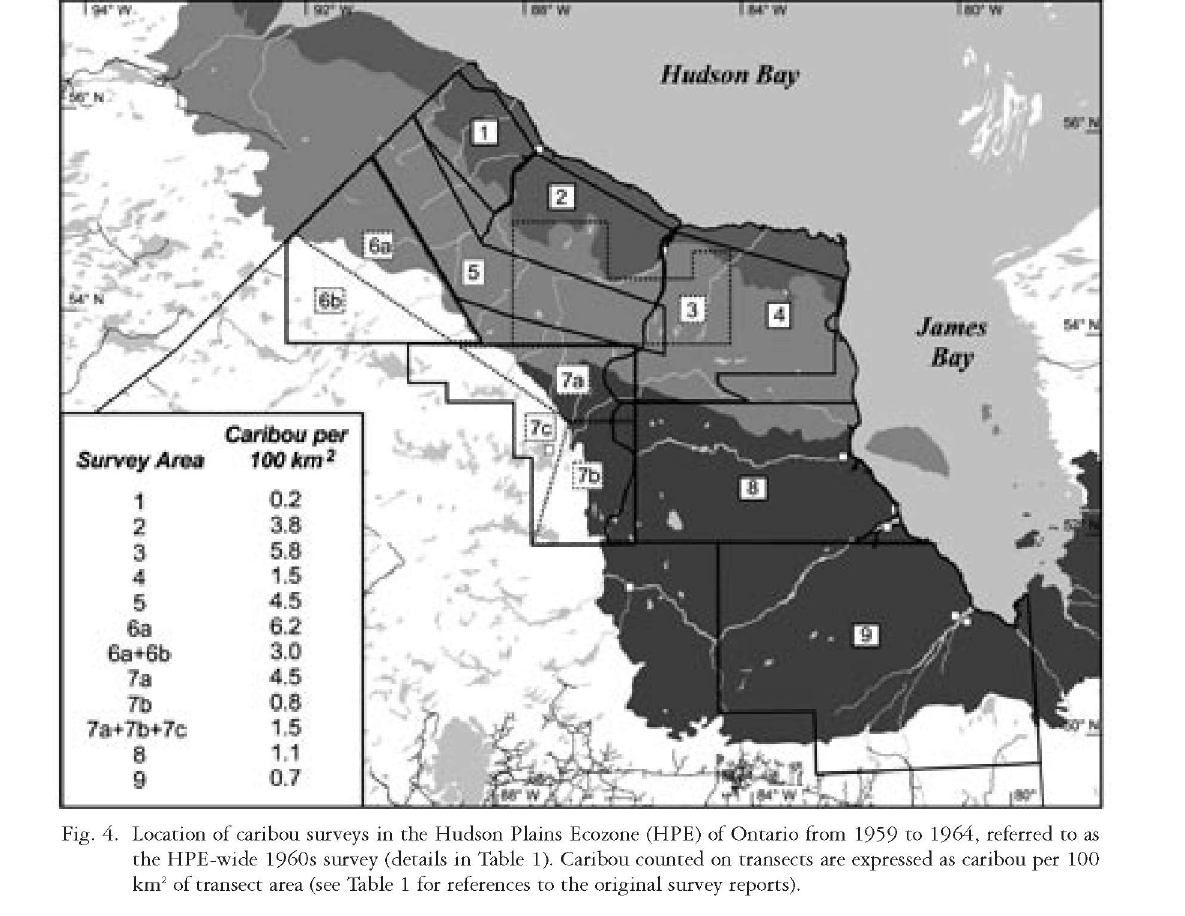
of Sutton Lake, and between the Winisk and Ekwan Rivers northeast of